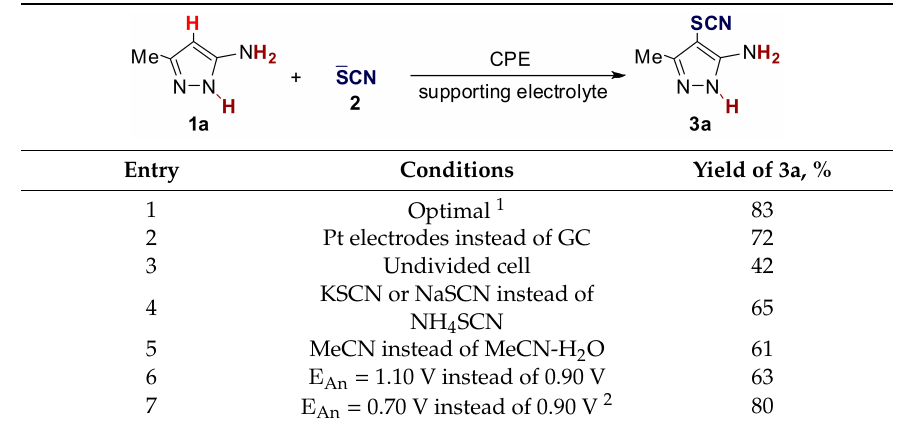
Table 1. E ff ect of electrolysis conditions on the yield of the target product 3a